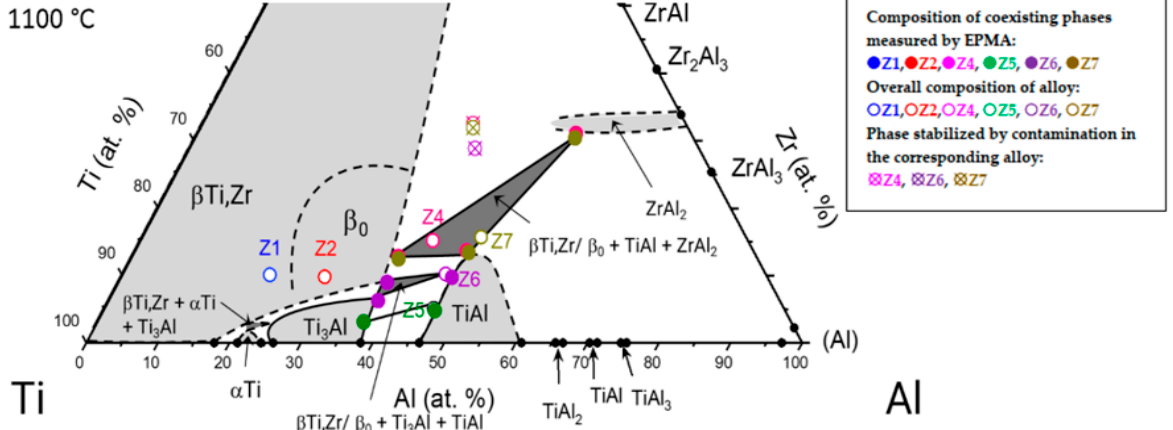
Figure 5. Partial Ti—Al—Zr isothermal section at 1100 °C. Table 4. Compositions and lattice parameters of the coexisting phases in alloys heat treated at 1100 °C/200 h; n.d.: not determined, but phase is detected.